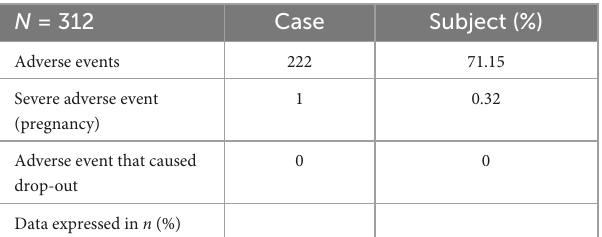
TABLE 4 Global quantification of adverse